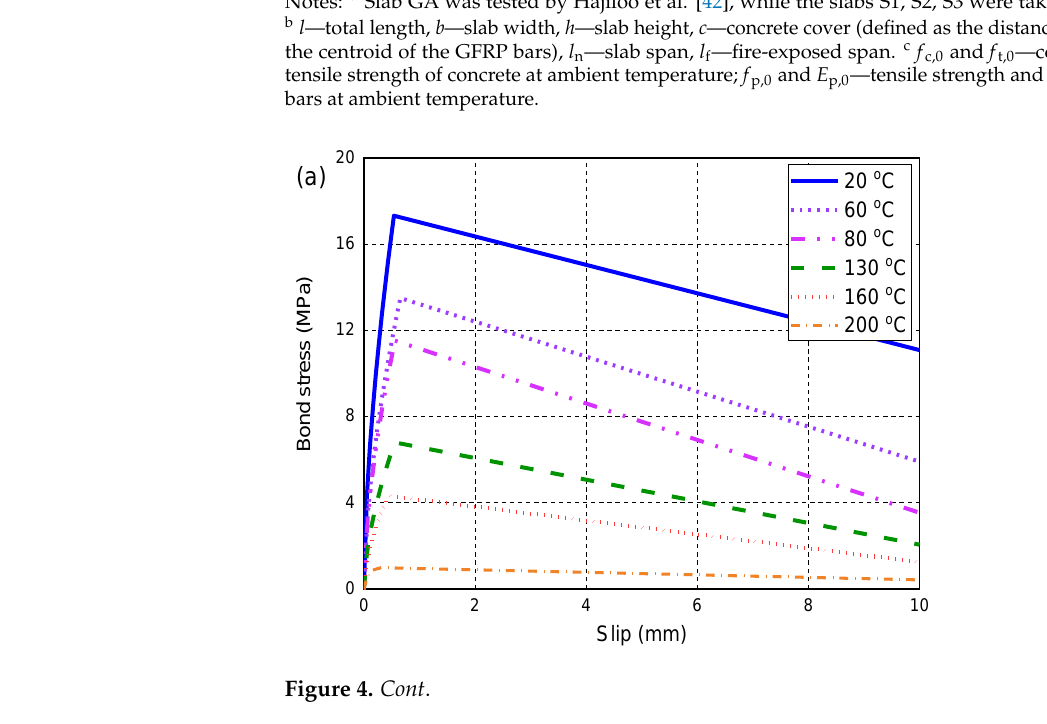
Figure 4. Local bond – slip model used in the FE model: ( a ) Slab GA; ( b ) Slabs S1, S2, and S3. 6.1. Hajiloo et al.’s Tests Hajiloo et al. [42] conducted fire tests on two full-scale GFRP bar-reinforced concrete slabs exposed to the ASTM E119 standard fire. The concrete cover depth of the slabs was set as 60 mm to ensure that a fire-resistance rating of 2 h could be achieved as per the current design guideline of Canada [6]. The geometric and material properties of the two slabs were the same except for the different surface treatment methods used for the GFRP bars (i.e., GA denoted the sand-coated GFRP bars while GB denoted the helically wrapped GFRP bars with the sand coating). A uniformly distributed load of 19.1 kN/m was applied